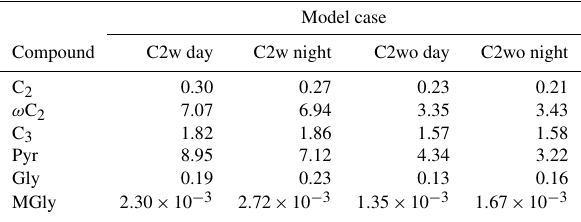
Table 3. Ratios of the concentrations of the modeled and measured DCRC compounds in the different model trajectories at Mt.